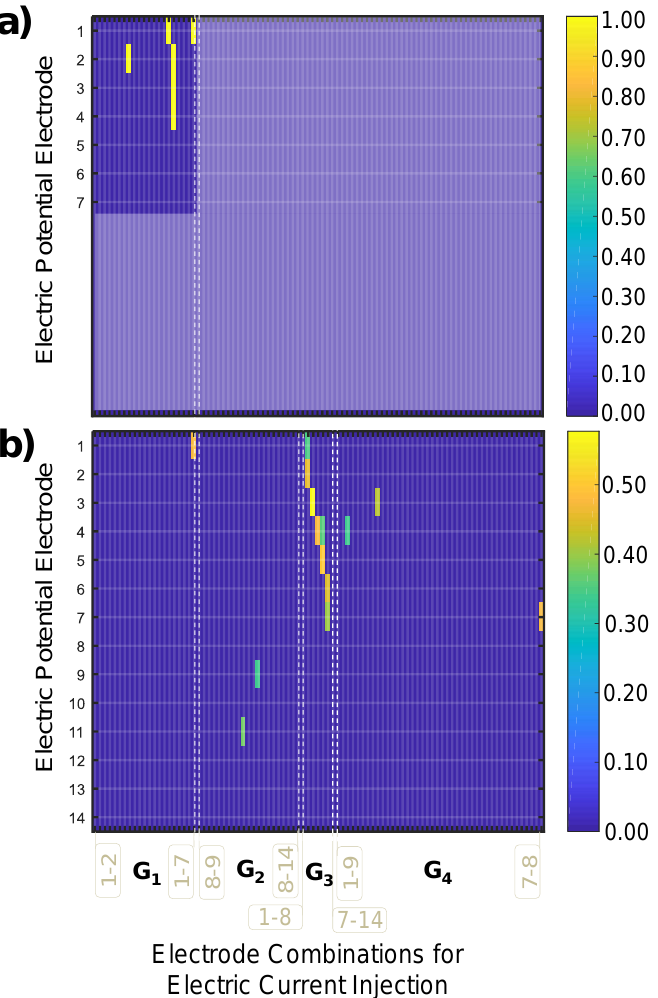
Figure 9. Results of Effective Independence on multi-probe schemes on [ 0 4 /90 4 ] s layup using ( a ) one-sided electrodes and ( b ) two-sided